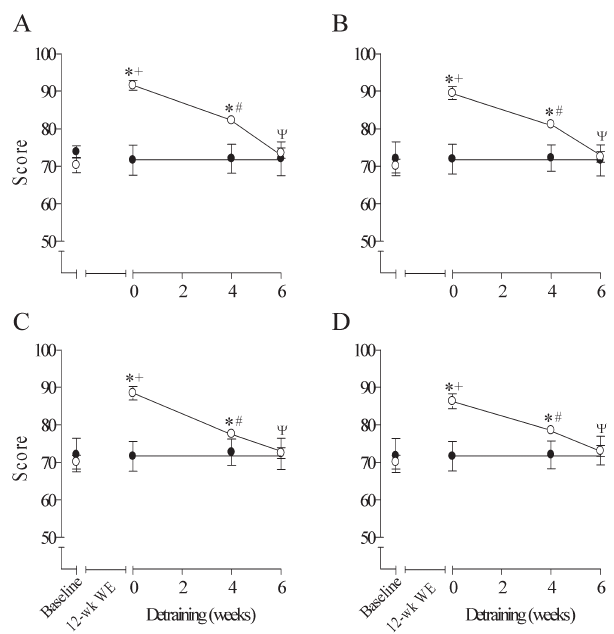
Figure 2 - Quality of life evaluated by the multiple domain questionnaires in baseline, after 12-week water-based exercise (WE) program and with 4 and 6 weeks of detraining (Panel A: physical domain; Panel B: psychological domain; Panel C: social domain and Panel D: environmental domain). Open circles shows the trained group; closed circles shows the untrained group. Two-way ANOVA followed by Tukey post hoc test was applied for comparisons. *p , 0.05 vs. baseline; + p , 0.05 vs. group without any training; # p , 0.05 vs. 12 weeks of WE; Y p , 0.05 vs. 4 weeks of